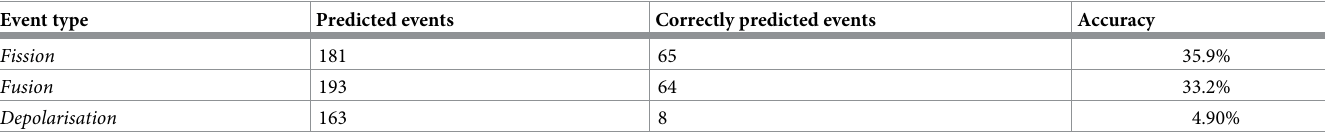
Table 6. The location prediction accuracies of the three-dimensional Pix2Pix GAN for mitochondrial fission, fusion and depolarisation events. Event